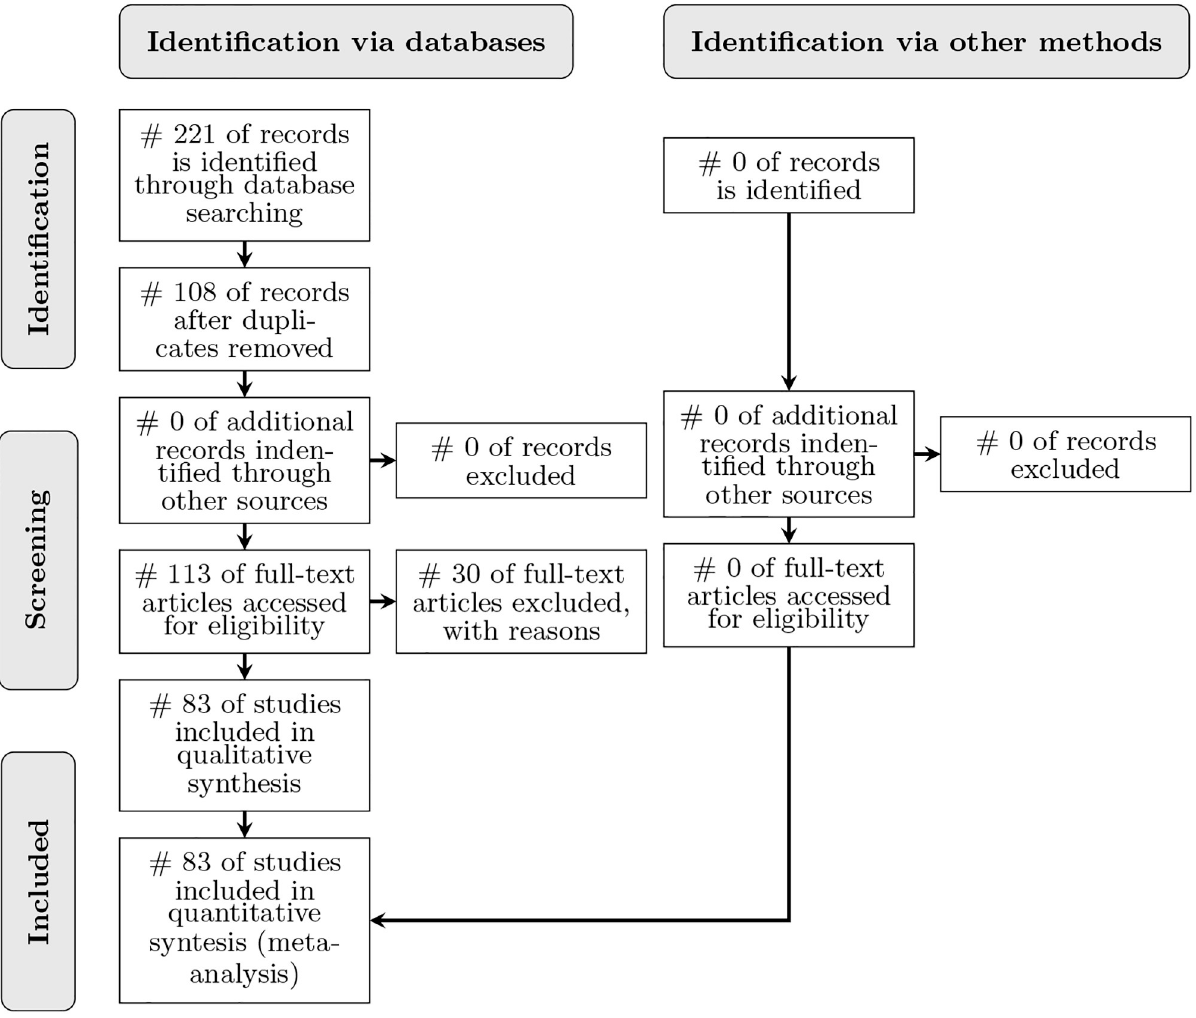
Fig 1. PRISMA flow diagram. It shows the stages of the search process as a flowchart diagram [38].